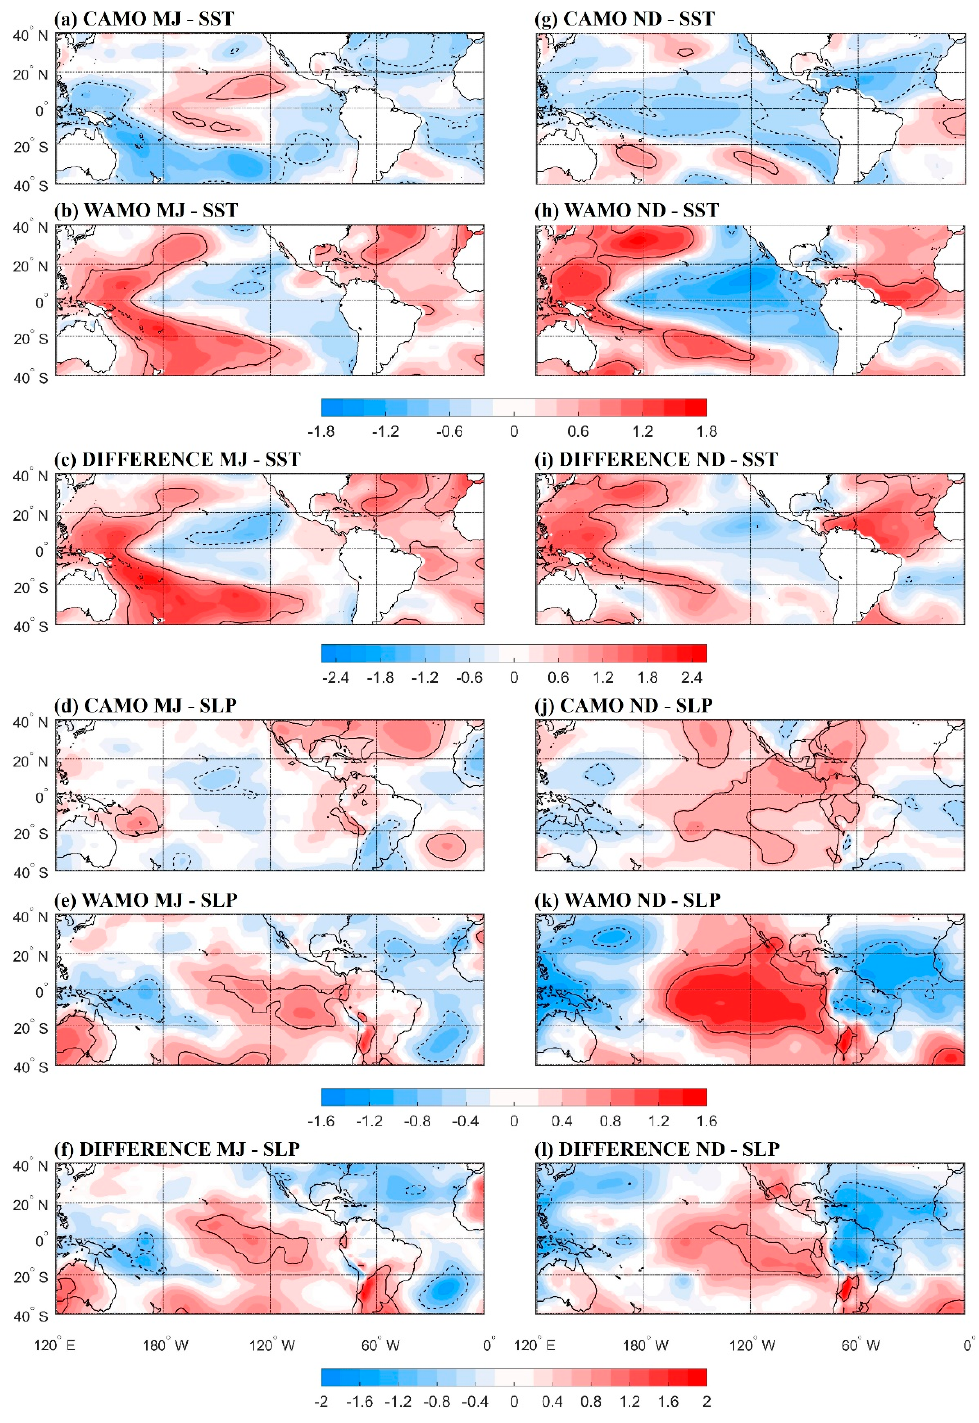
Figure 5. MJ standardized anomaly patterns associated with extreme flow events at Bellavista (left column) for the SST during: ( a ) CAMO, ( b ) WAMO, and ( c ) WAMO minus CAMO and for the SLP during ( d ) CAMO, ( e ) WAMO, and ( f ) WAMO minus CAMO. ND standardized anomaly patterns associated with extreme flow events at Bellavista (right column) for the SST during ( g ) CAMO, ( h ) WAMO, and ( i ) WAMO minus CAMO and for the SLP during ( j ) CAMO, ( k ) WAMO, and ( l ) WAMO minus CAMO. The contour range is 0.2 standard deviations. Shaded areas in red (blue) indicate positive (negative) values. The continuous (dashed) line encompasses significant positive (negative) values at the confidence level of 95%.